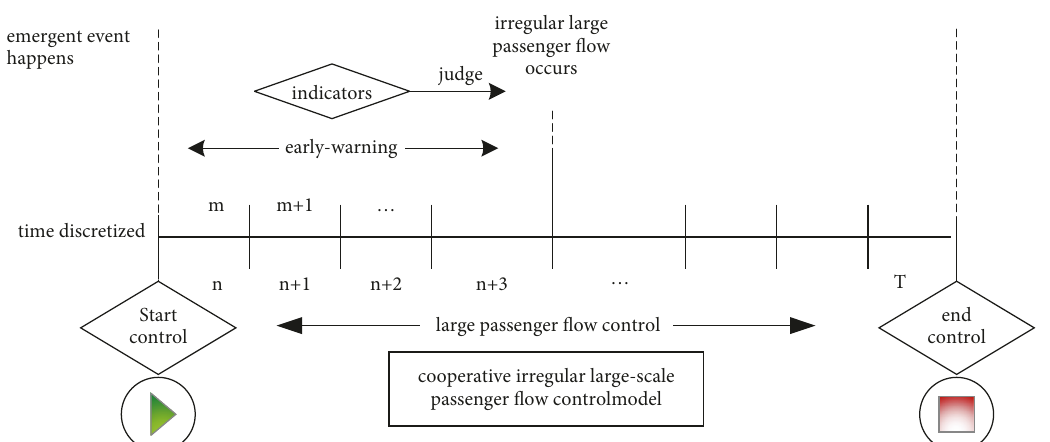
Figure 4: Procedure for passenger flow control for